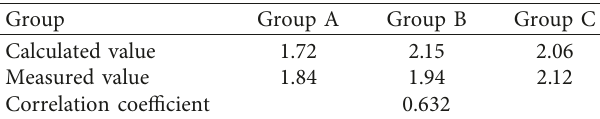
Table 8: The comparison of the calculated and measured values for HCCSEB